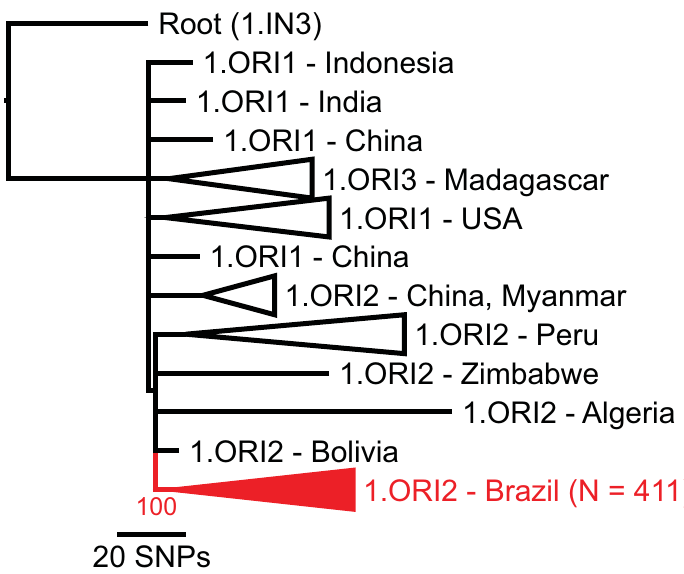
Fig 1. Yersinia pestis 1.ORI population phylogeny. Maximum parsimony phylogeny based on single nucleotide polymorphisms (SNPs) identified among 461 Y . pestis genomes belonging to the 1.ORI population, including 411 Brazilian Y . pestis strains (S1 Table, S2 Table). All 411 Brazilian Y . pestis genomes were assigned to a single monophyletic clade (red) with 100% bootstrap support. The phylogeny was rooted on strain D106004 (Genbank accession No. GCA 000022805.1), a member of the 1.IN3 Y . pestis